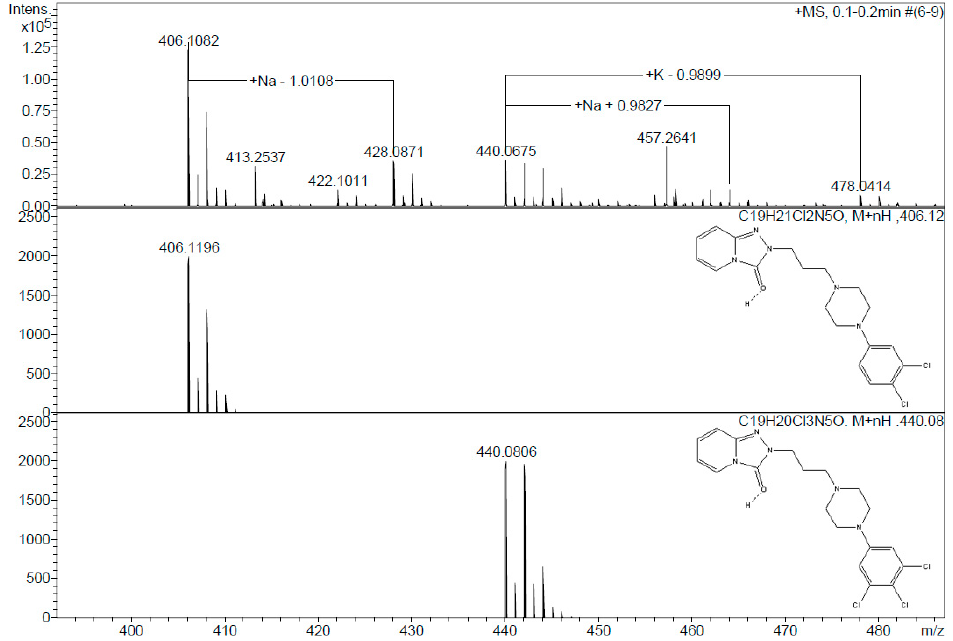
Figure 3. ESI ‐ mass spectra of the conversion products of the CPO ‐ catalyzed oxidation of trazadone Figure 3. ESI-mass spectra of the conversion products of the CPO-catalyzed oxidation of trazadone recorded in negative mode. recorded in negative